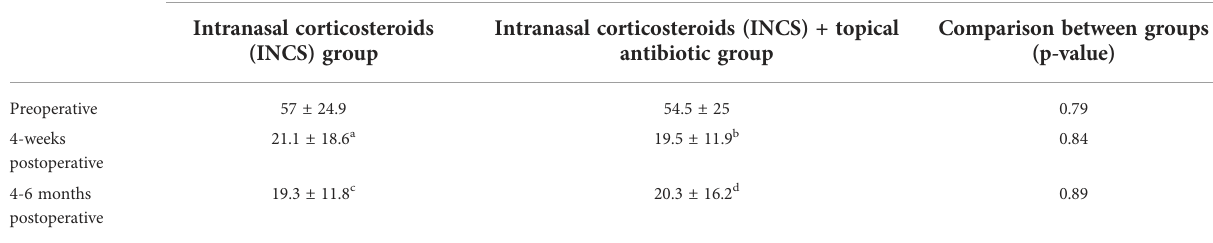
TABLE 2 Changes over time on sinonasal outcome test (SNOT-22) in the control and intervention groups (mean, S.D.). SNOT-22 Intranasal corticosteroids Intranasal corticosteroids (INCS) + topical Comparison between groups (INCS) group antibiotic group